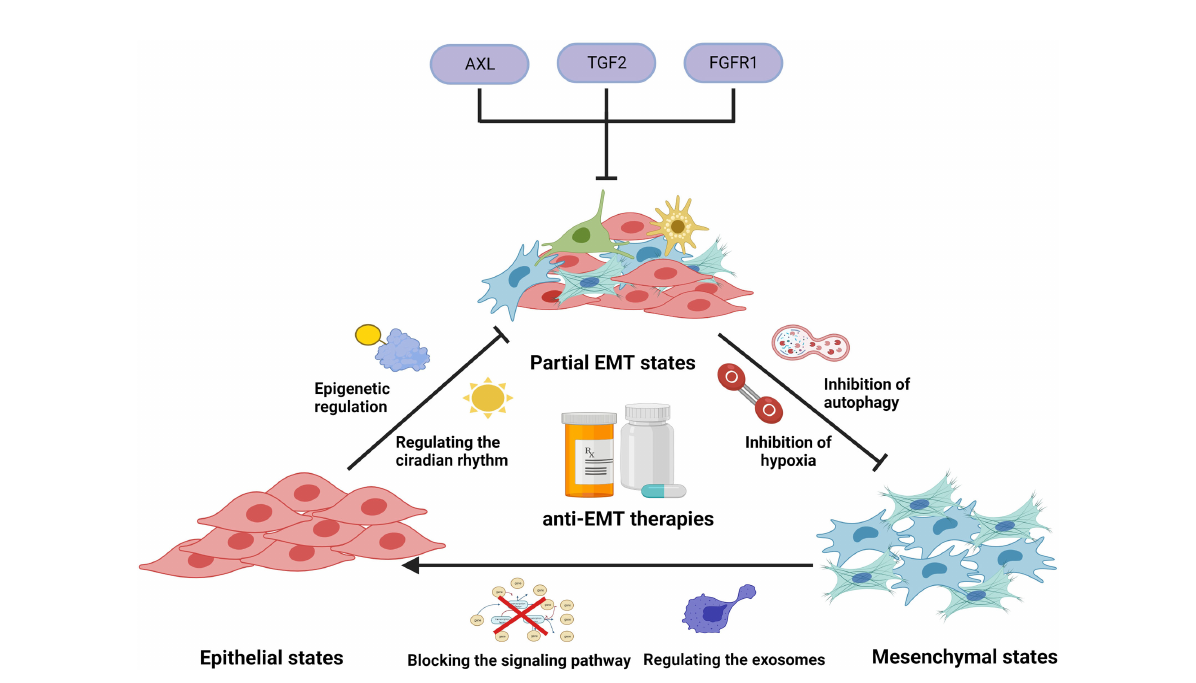
FIGURE 4 Illustration representing several anti-EMT therapies to overcome drug resistance. In clinical applications, platinum-based drugs can cause the induction and development of EMT by activating EMT-related signals, regulating circadian rhythms, regulating epigenetics, causing hypoxia, inducing autophagy, and stimulating exosome secretion, thereby generating tumor cells ’ resistance to PBDs. Use of modality-related inhibitors can prevent and reverse EMT, enhancing the ef fi cacy of PBDs. In addition, some small molecules can target EMT cells and prevent them from entering a drug-resistant